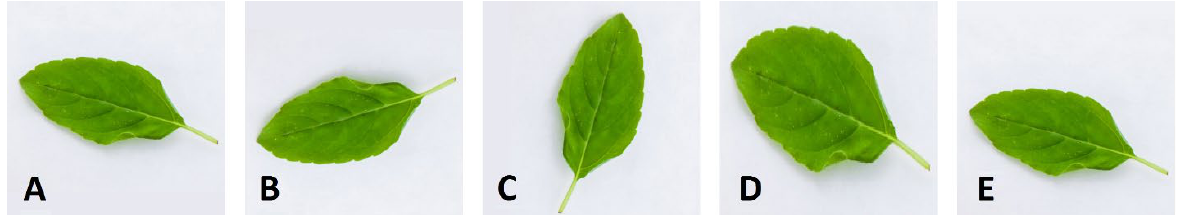
Figure 3. Image augmentation strategies. (A) is the original image, while (B-E) represent various augmentation